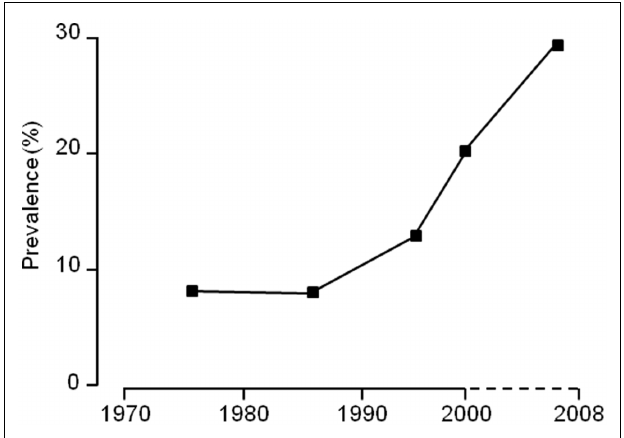
FIGURE 1 |The change in incidence of overweight and obese children in the United Kingdom between 1980 and